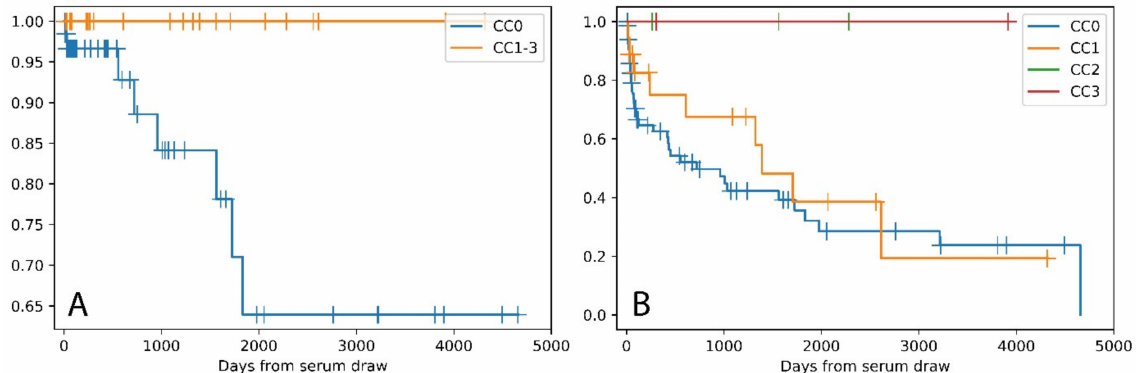
Figure 3. Kaplan-Meier curves of time from serum draw to ATCMR IA,B in the different Cav-1 classifier (CC) groups. ( A ) The eight events of ATCMR IA,B only occurred in the lowest CC group (CC0), p < 0.005 (logrank test). ( B ) Event was defined as borderline or ATCMR IA,B. The 42 events only occurred in the lower CC groups (CC0,1), p < 0.005 (multivariate logrank